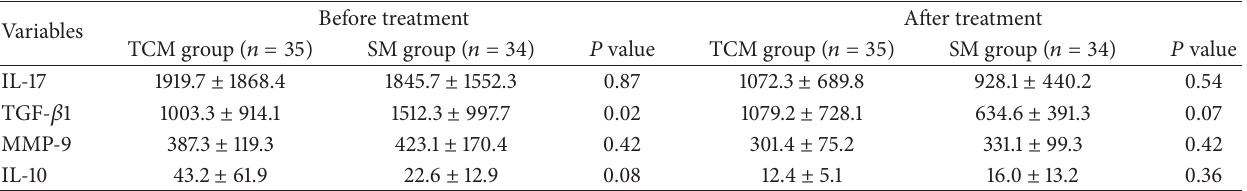
Table 4: Comparison of the peripheral blood levels of IL-10, IL-17, TGF- 𝛽 1, and MMP-9 between the TCM group and SM group before and after treatment (pg/mL, MMP-9 ng/mL, mean ± SD).